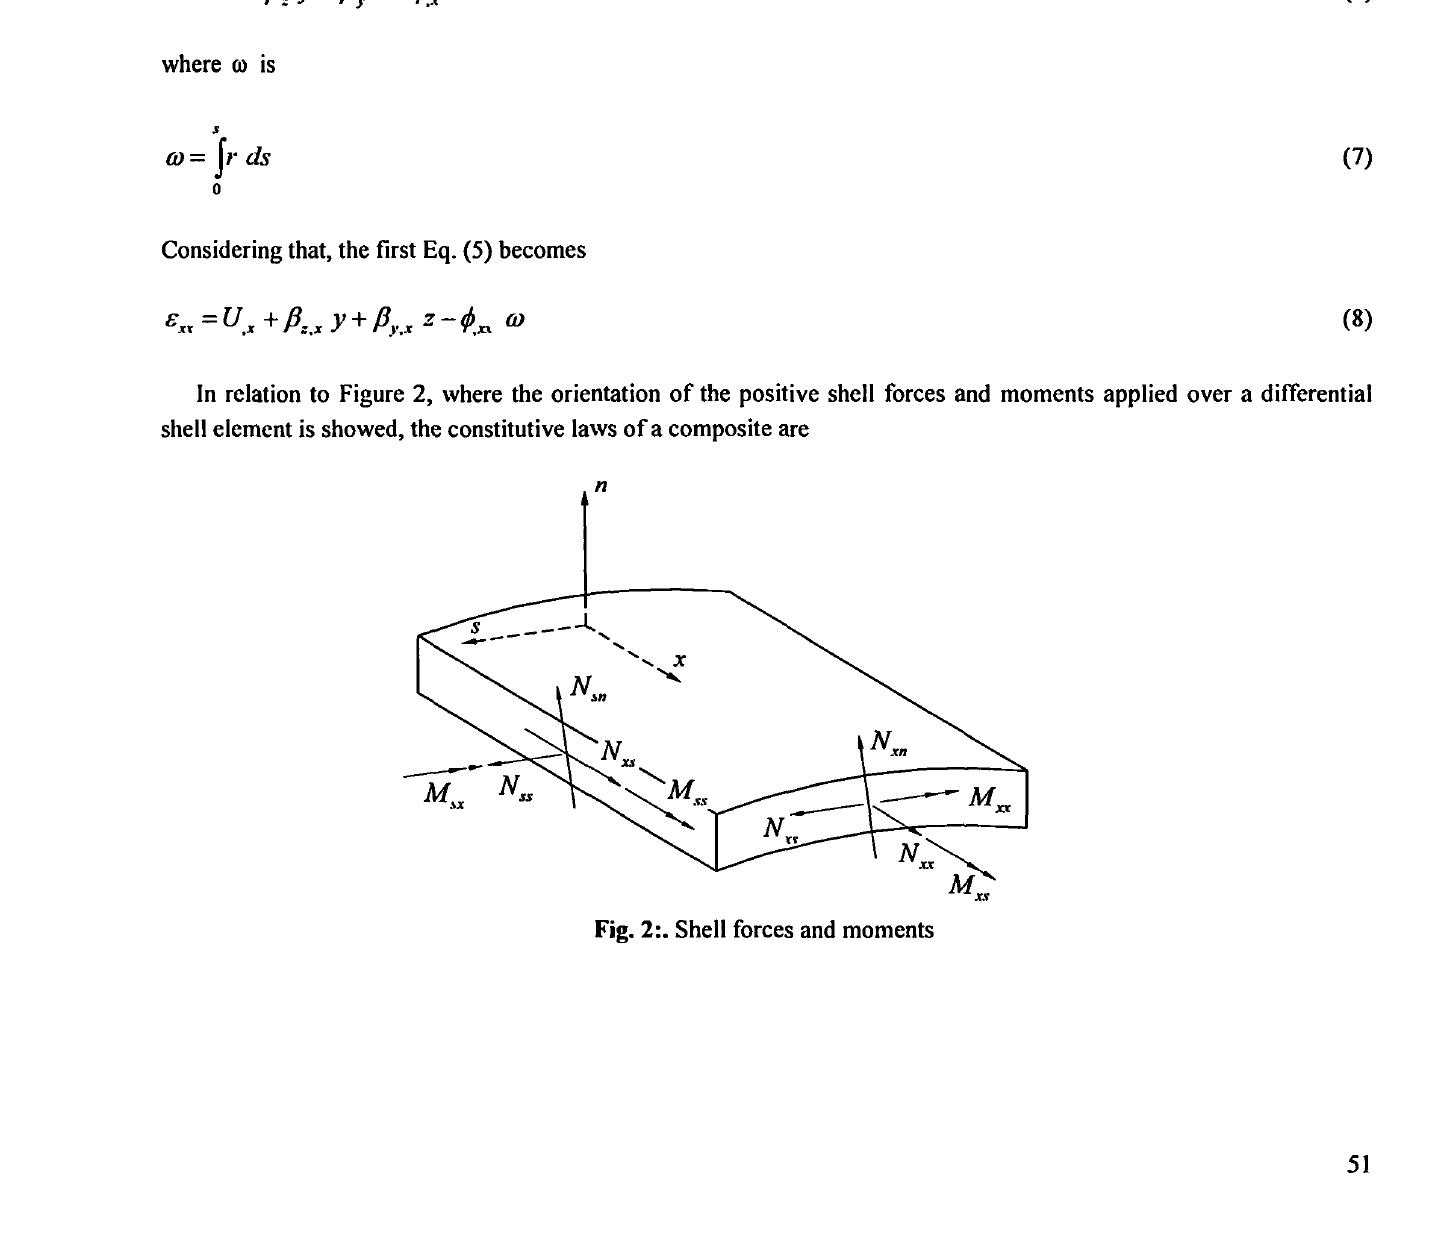
Fig. 2:. Shell forces and